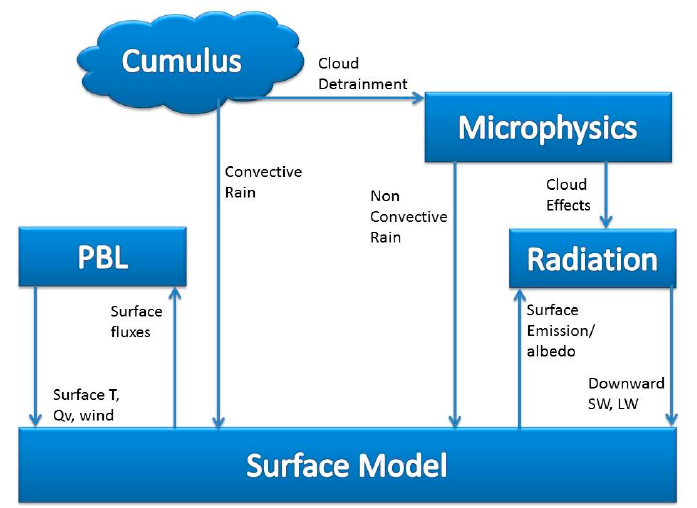
Figure 2. Interactions between WRF parameterization schemes.